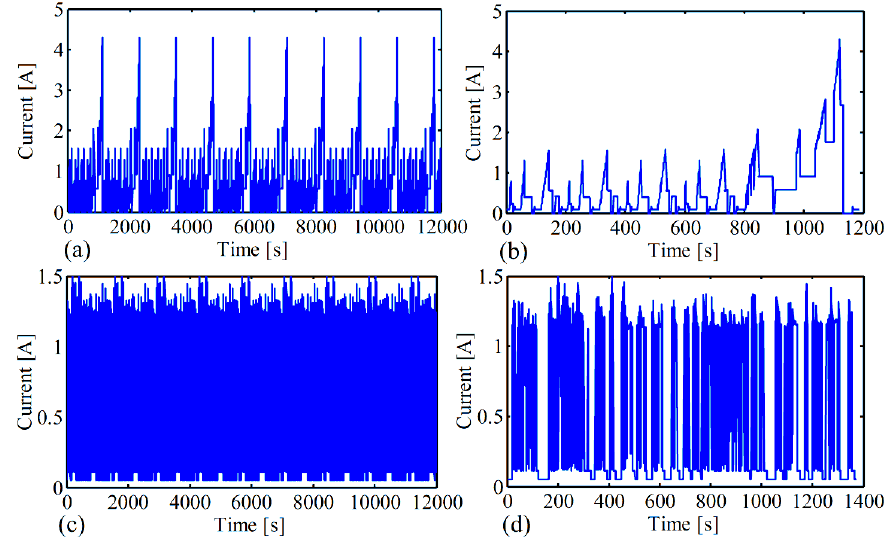
Figure 5. Current profiles: ( a ) New European Driving Cycle (NEDC); ( b ) zoom figure of ( a ); and ( c ) Federal Urban Driving Schedule (FUDS); ( d ) zoom figure of